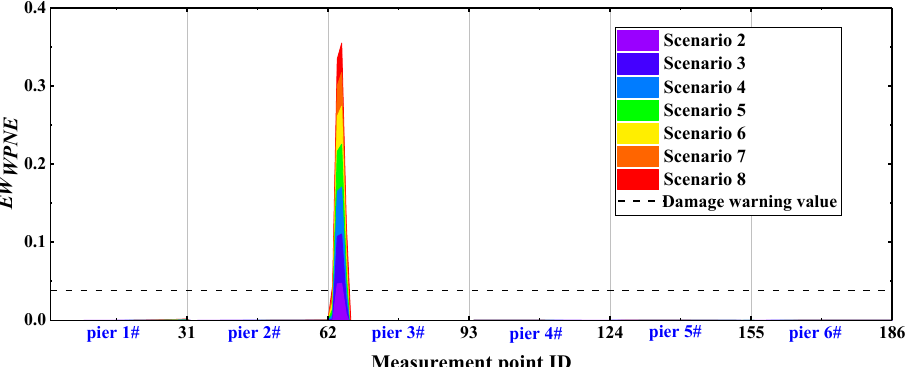
Figure 13. EW WPNE identification results of damage I of 6 bridge piers.